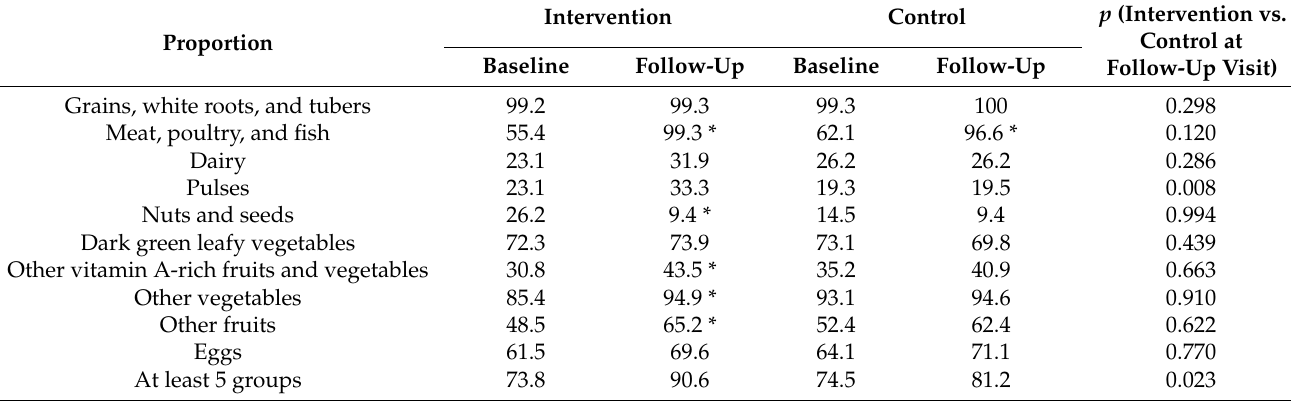
Table 3. The proportion of participants who consumed MDD-W food